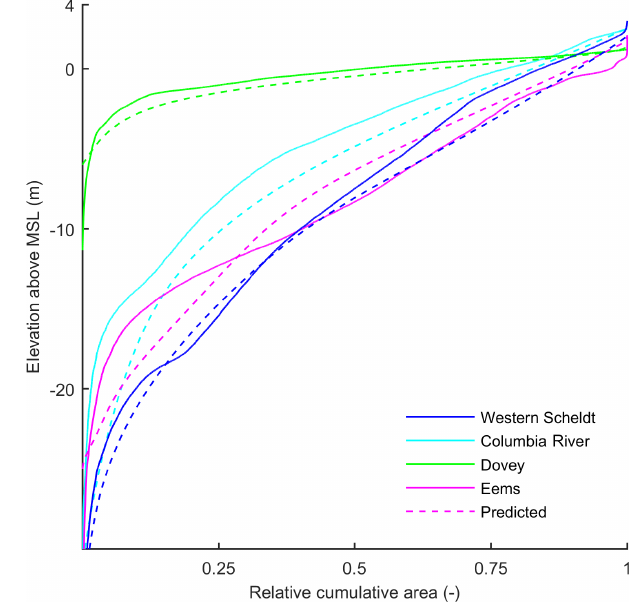
Figure 11. Comparison of measured and predicted width of inter- tidal and subtidal width. The (solid) line of equality indicates a per- fect fit and dashed lines indicate a deviation of a factor of 2. The percentage of measurements within these margins is indicated in